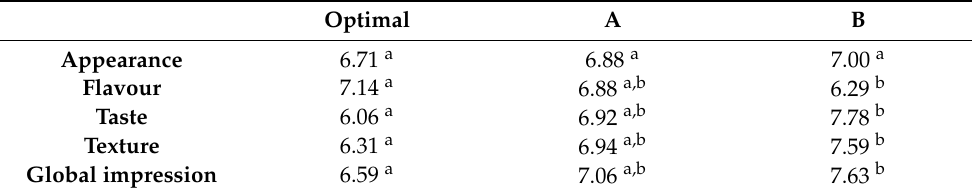
Table 7. Sensory analysis of optimal cereal bar in comparison to the commercial forms (A and